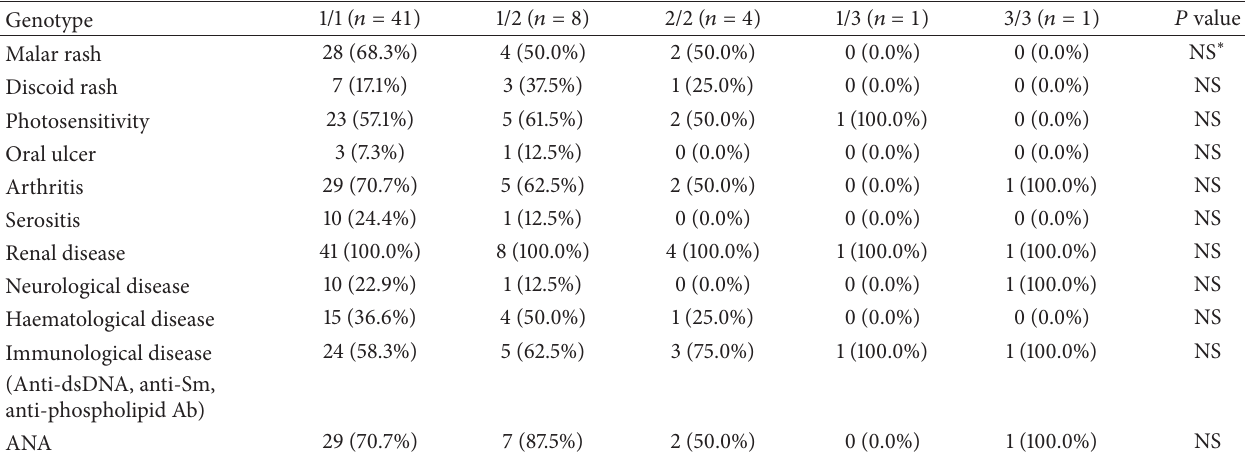
Table 3: Comparison between the genotypes and the ACR criteria for